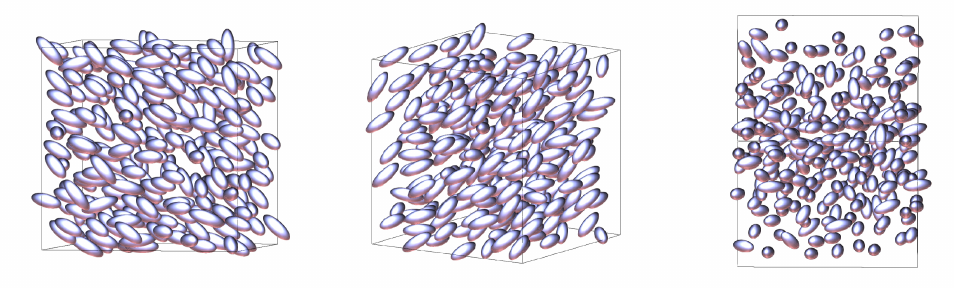
Figure 4. Snapshot of a nematic phase at T ∗ = 1.0 and P ∗ = 3.0 from three different angles.